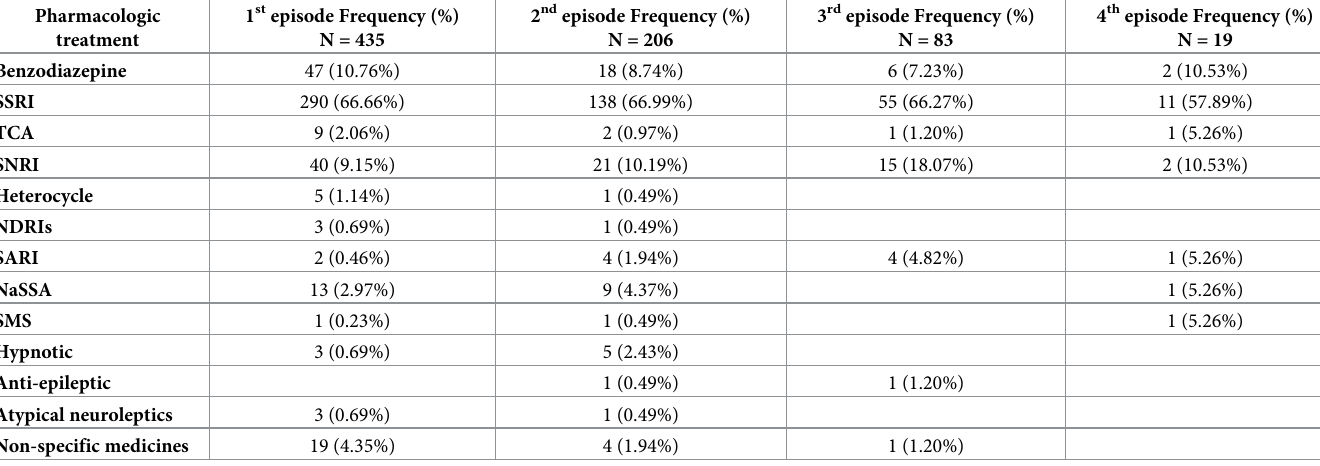
Table 4. Description (frequency and percentage) of pharmacologic treatment (ATC category) in monotherapy for each depression episode. Pharmacologic